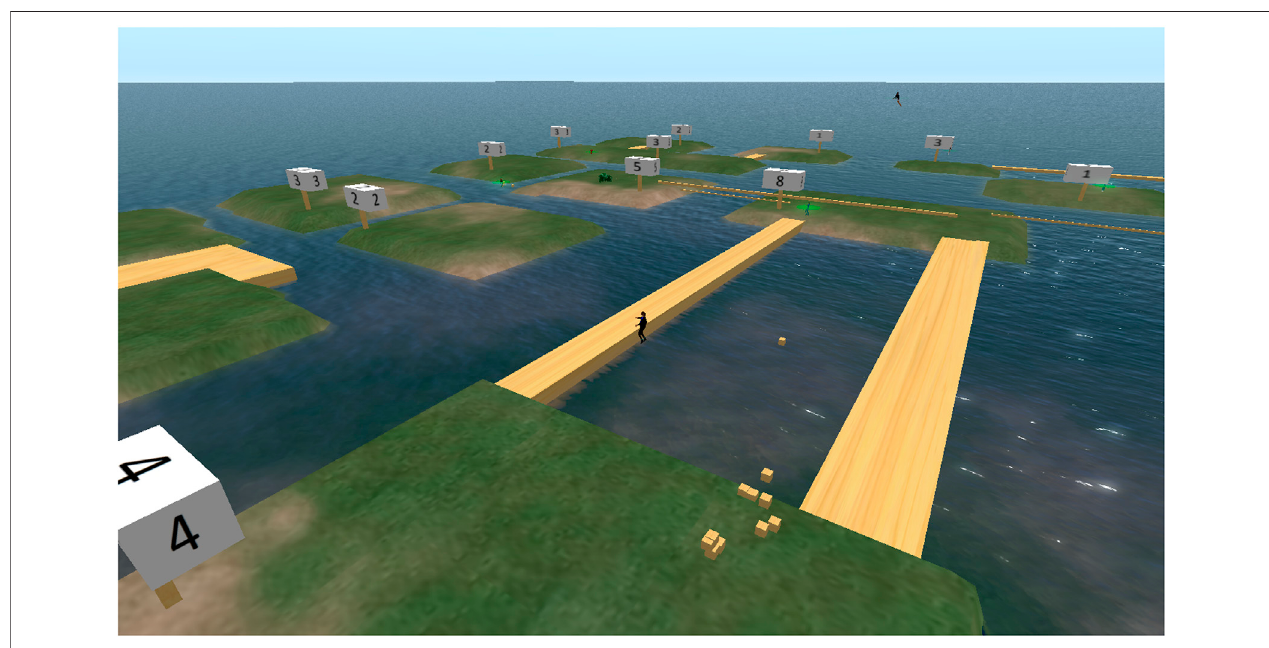
FIGURE 5 | Hashiwokakero activity in progress.